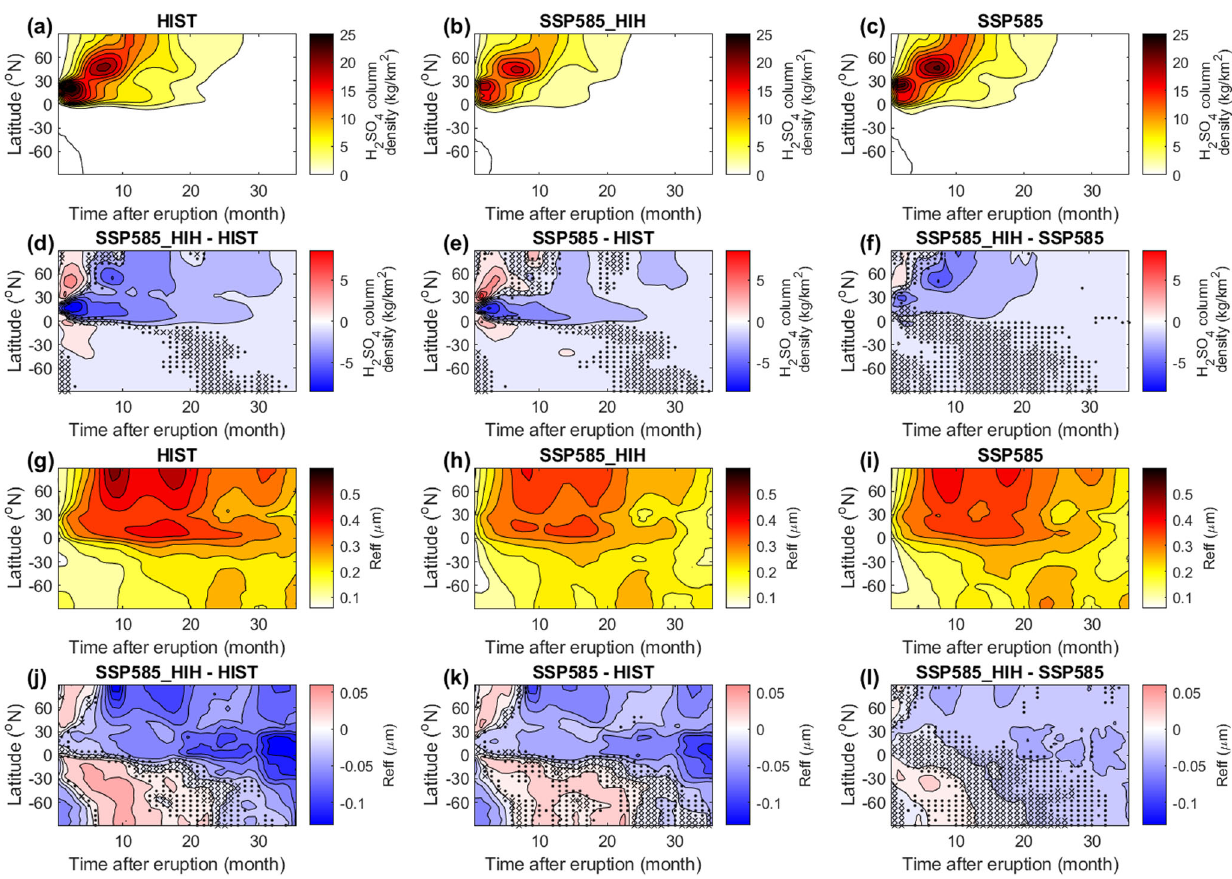
Fig. 6 Time-latitude evolution of the H 2 SO 4 column density and aerosol effective radius for the large-magnitude eruption. a – f H 2 SO 4 column density (kg m − 2 ). g – l Aerosol effective radius ( μ m). Individual panels either show values for one of the three scenarios or the pairwise difference between scenarios and are labeled accordingly. For panels showing the pairwise difference, dots highlight areas where changes are not signi fi cant at 95%, and crosses highlight areas where the difference is not signi fi cant at the 80% level. The HIST scenario represents the historical climate and the SSP585 scenario is an upper-end future climate scenario. SSP585_HIH is as SSP585 but uses SO 2 injection heights consistent with the HIST